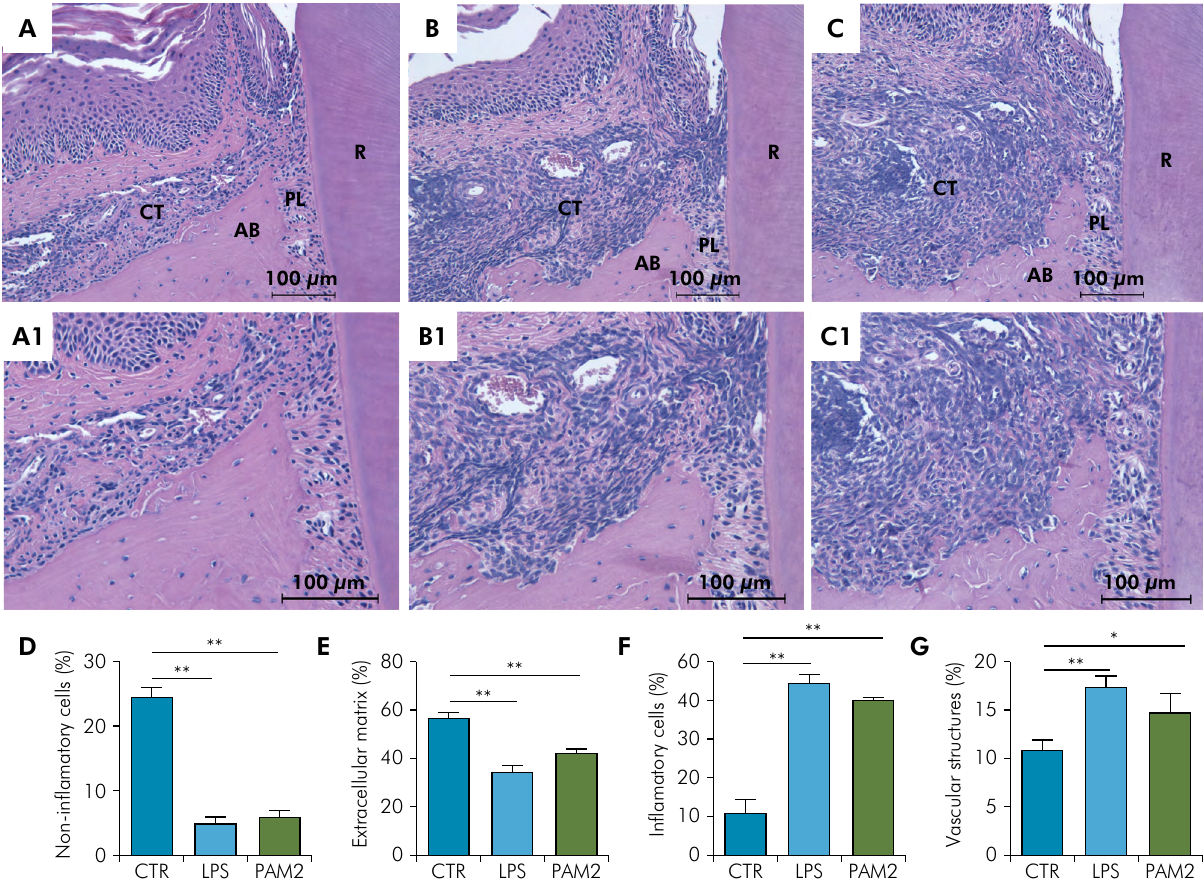
Figure 2. Representative H&E-stained images from the maxilla, and quantification of stereometric findings: (A-C): CTR (n = 7), LPS (n = 7) and PAM2 (n = 7) groups, respectively. Original magnification, 200x. (A1-C1) CTR, LPS and PAM2 groups, respectively. Original magnification, 400x. (D-G): Quantification of relative presence of fibroblasts, extracellular matrix, inflammatory cells, and vascular